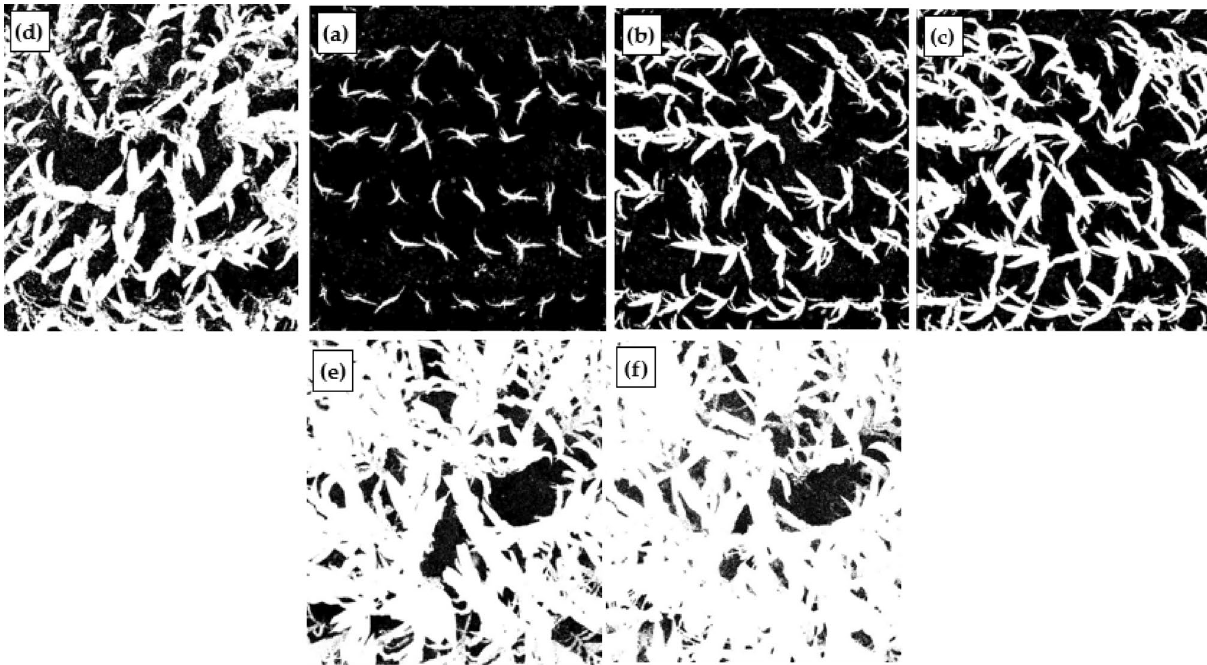
Figure 6. The time series of extracted leaf-cover from the digital images in site 1: ( a ) May 30; ( b ) June 7; ( c ) June 13; ( d ) July 4; ( e ) July 16; ( f ) August